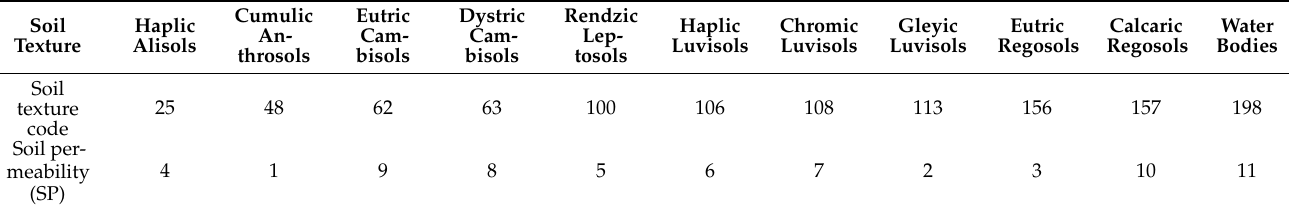
Table 2. Soil permeability of various soil textures.